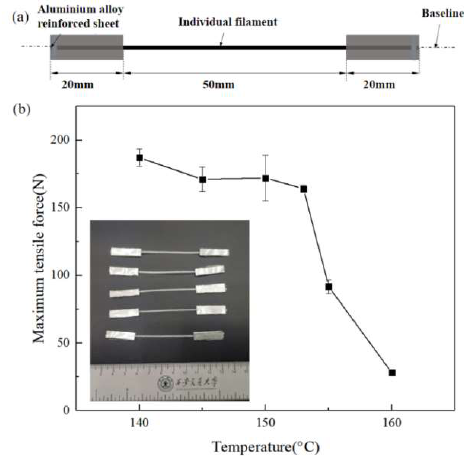
Figure 3. ( a ) Individual filament tensile test specimen. ( b ) Mechanical properties of single UHMWPE fiber bundles obtained at various temperatures.